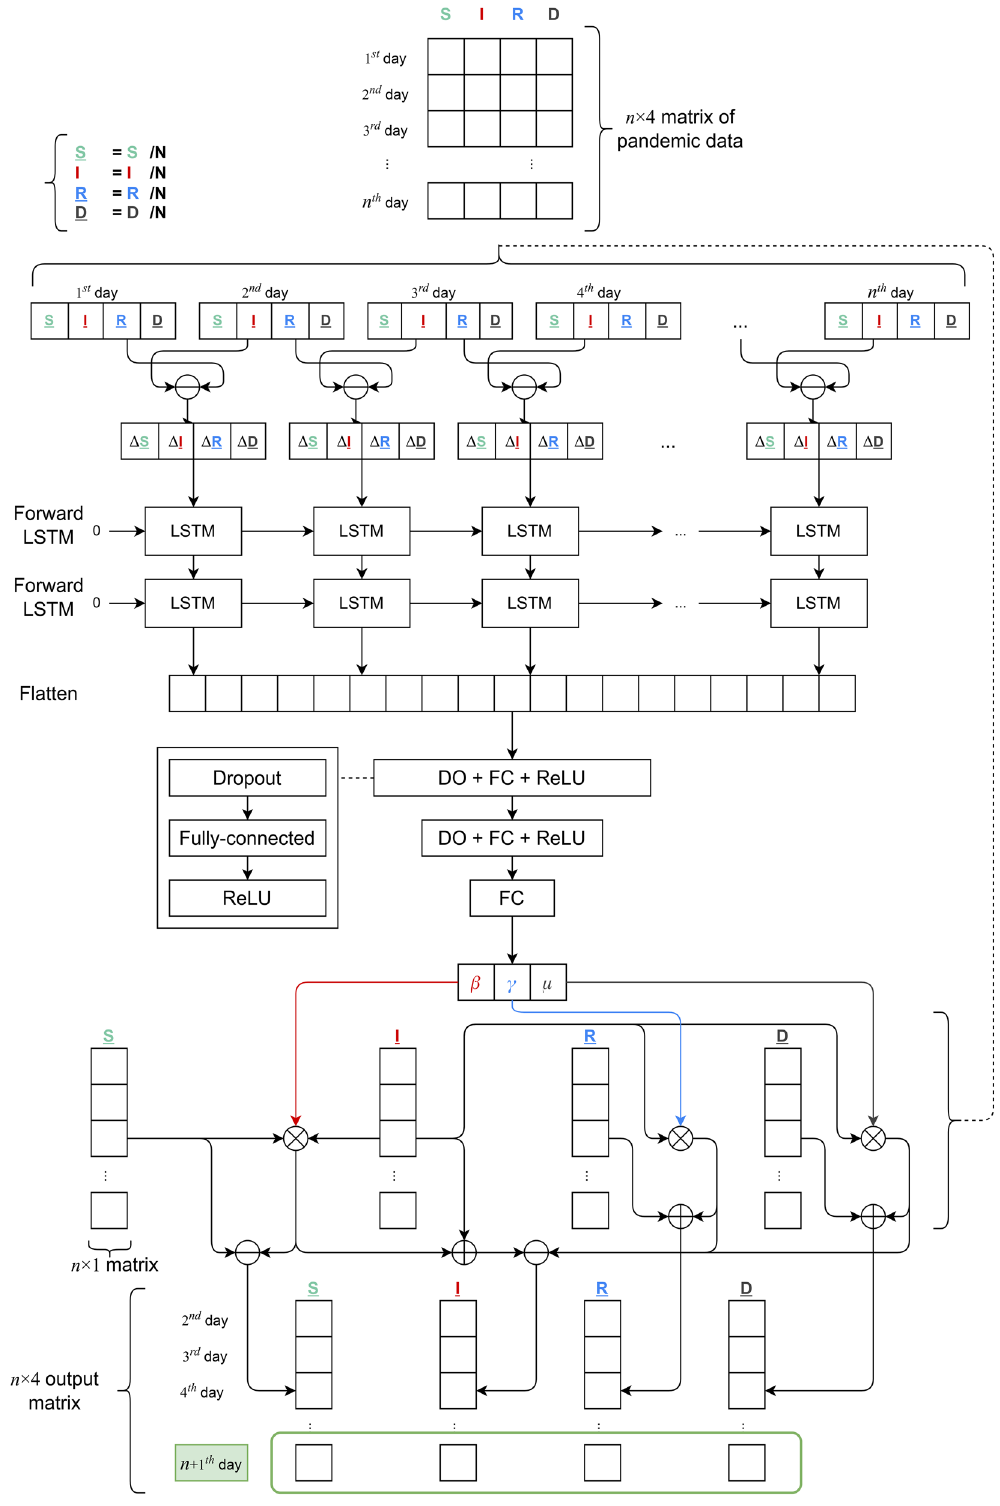
Figure 7. The architecture of BeCaked